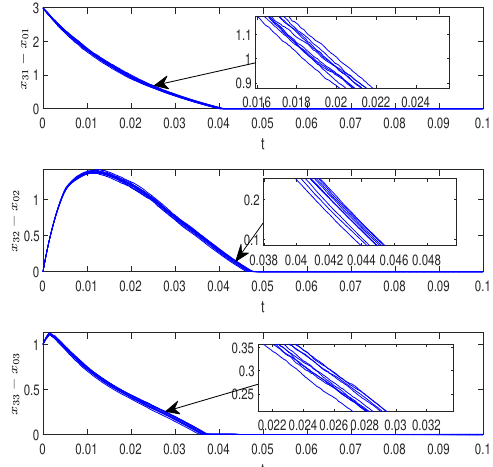
Figure 4. Ten paths of the tracking error between the 3rd subchain and the leader with protocol (6). Fig.4. 10 paths of the tracking error between the 3-th subchain and the leader with protocol (4.2).